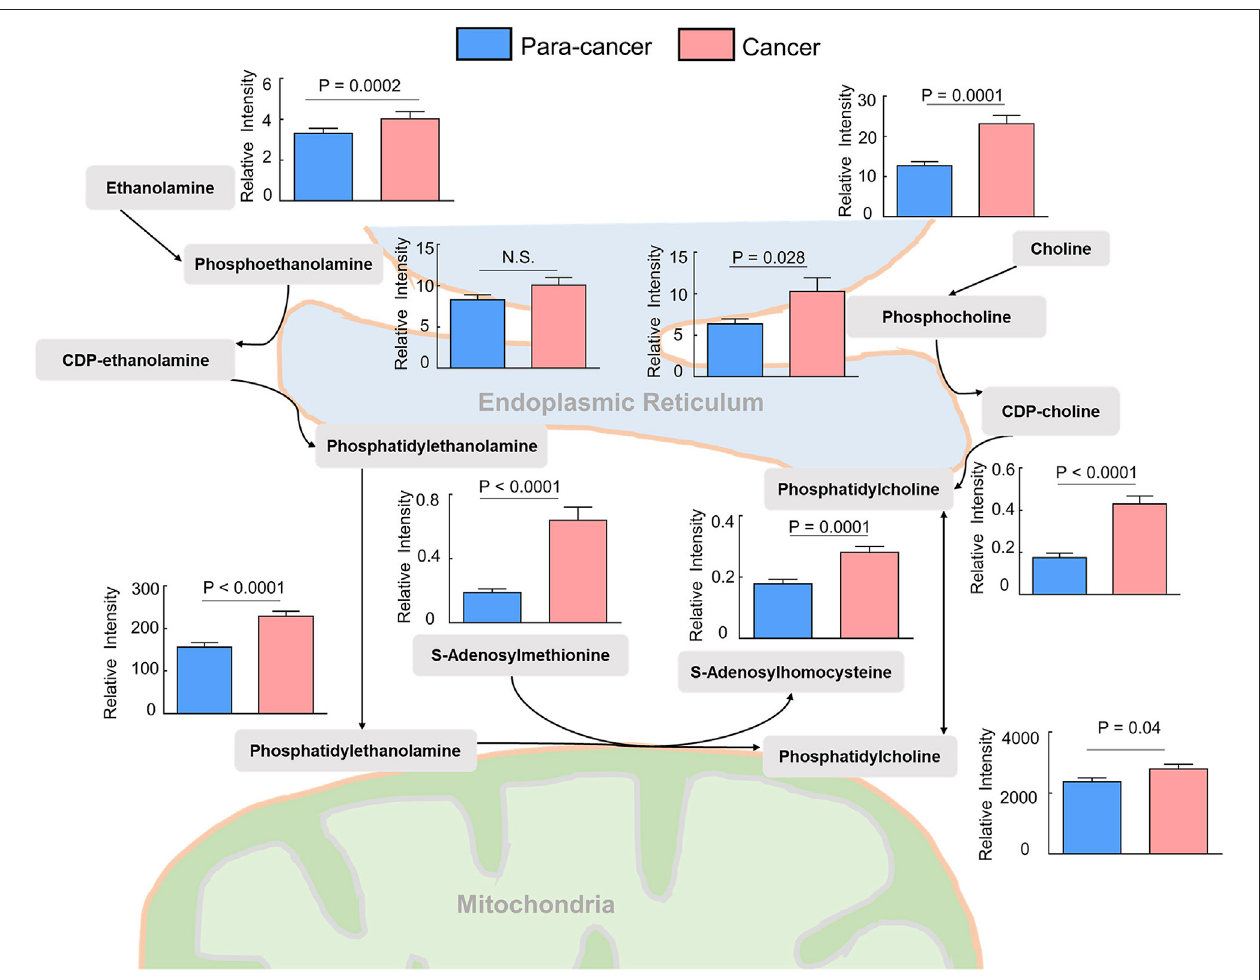
FIGURE2| Upregulated phosphatidylcholineand phosphatidylethanolamine biosynthesispathway inESCCtissuescomparedwithpericarcinoustissues.( n (cid:2) 28. Data were expressed as mean ± SEM.)